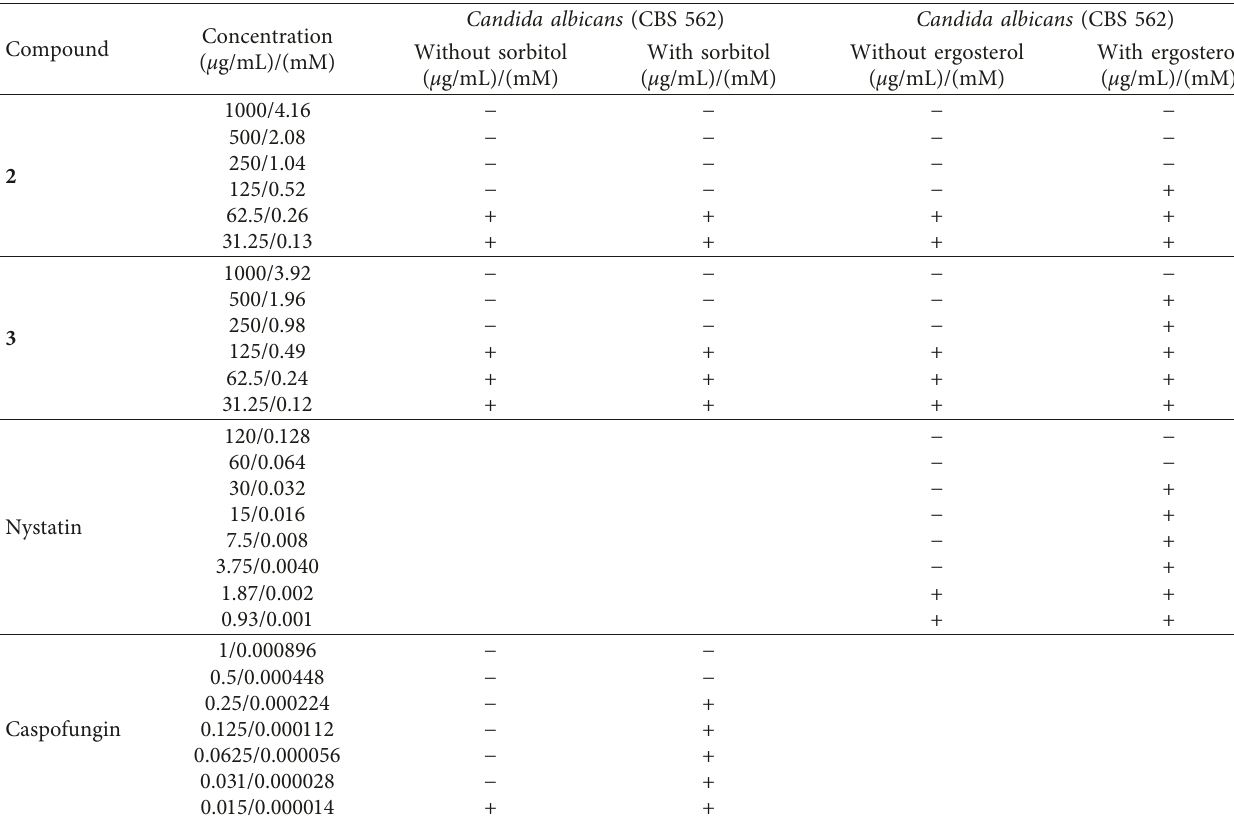
Table 2: MIC values in ( µ g/mL) and (mM) of esters 2 and 3 in the absence and presence of sorbitol (0.8M) and ergosterol against Candida albicans .